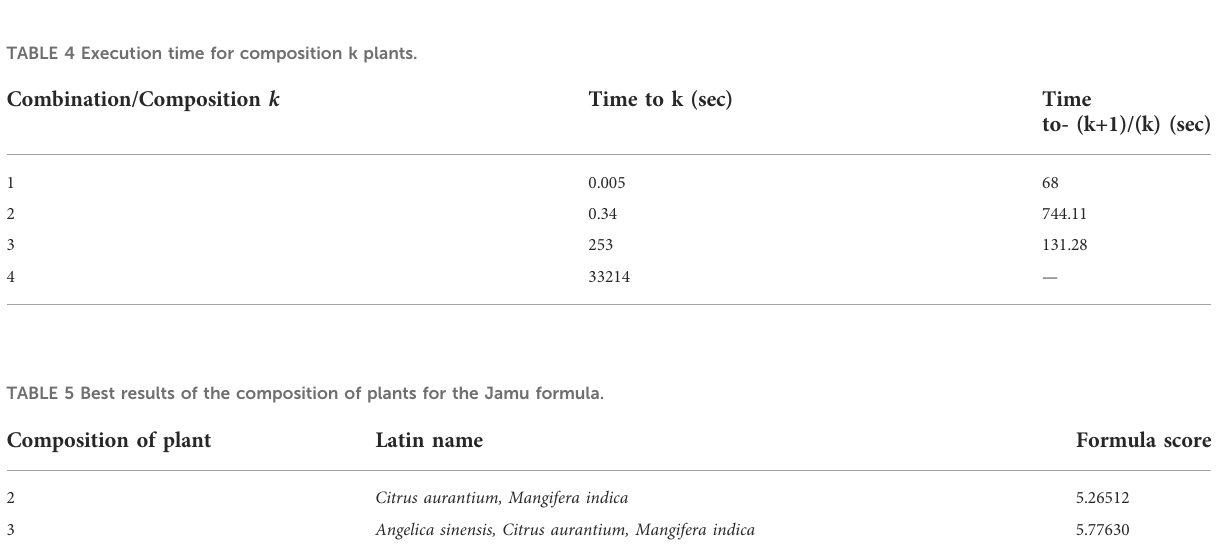
TABLE 4 Execution time for composition k plants.